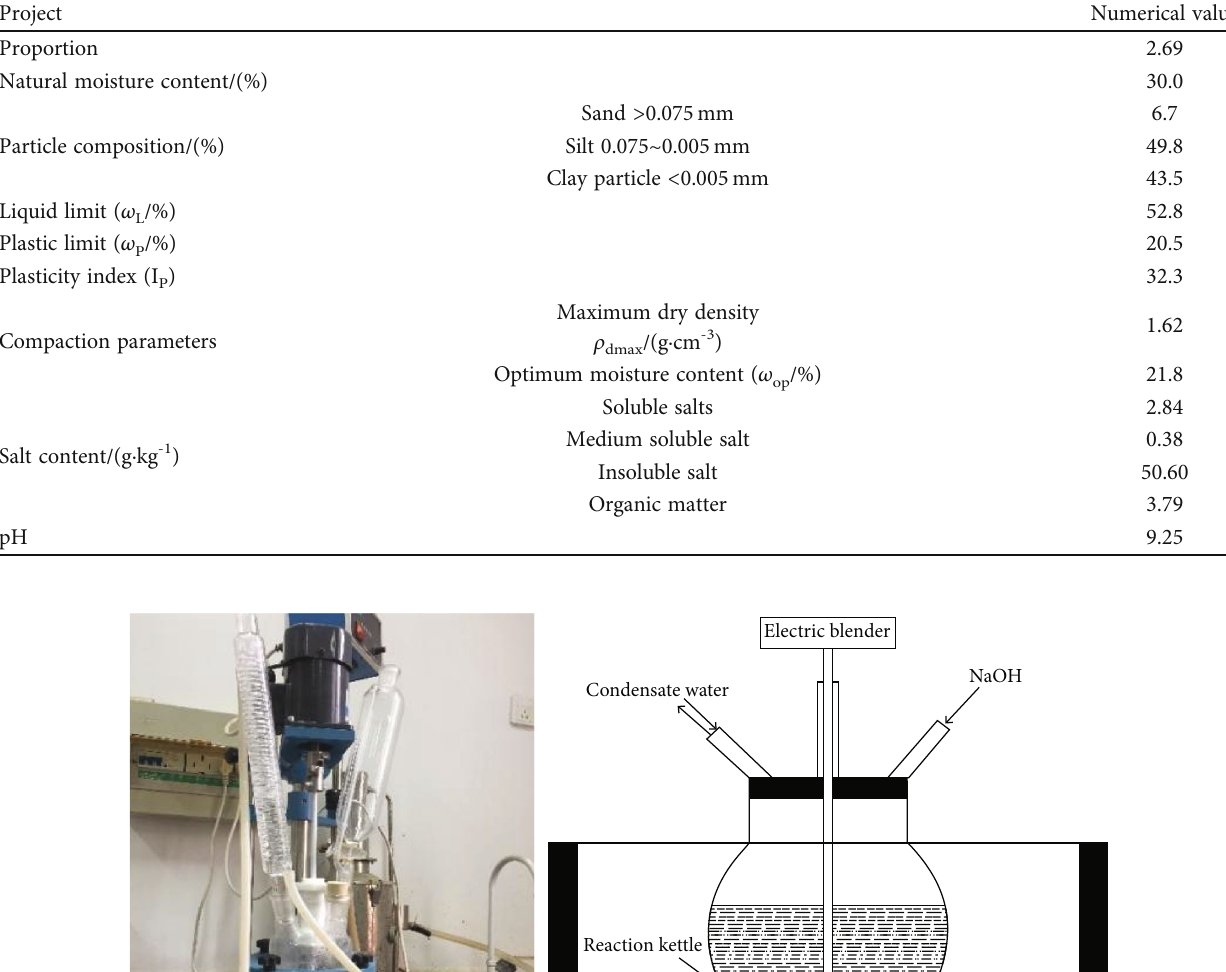
Table 1: Physical and chemical properties of dispersive soil.